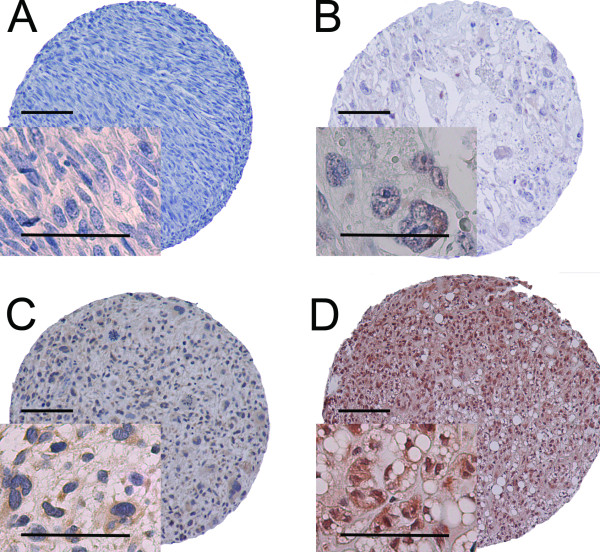
IHC analysis of TMA of non-GIST STS representing different expressions of markers belonging to PI3K/Akt pathway in tumor cells. A, Leiomyosarcoma, histological grade I, PTEN, negative staining, score 0; B, Pleomorphic liposarcoma, histological grade III, p-Akt Thr308, weak nuclear staining, score 1; C, Undifferentiated pleomorphic sarcoma, histological grade III, PI3K, moderate cytoplasmic staining; score 2; D, Dedifferentiated liposarcoma, histological grade II, p-Akt Ser473, strong both nuclear and cytoplasmic staining, score 3. All calibration bars correspond to 100 μm in the overview images (objective 10×) and 50 μm in the pictures taken at high magnification (objective 40×). Abbreviations: IHC, immunohistochemistry; TMA, tissue microarray; non-GIST STS, non gastro-intestinal stromal tumor soft-tissue sarcoma; PTEN, phosphatase and tensin homolog; p-Akt Thr308, Akt phosphorylated at threonin 308; PI3K, phosphoinositide 3-kinase; p-Akt Ser473, Akt phosphorylated at serin 473.